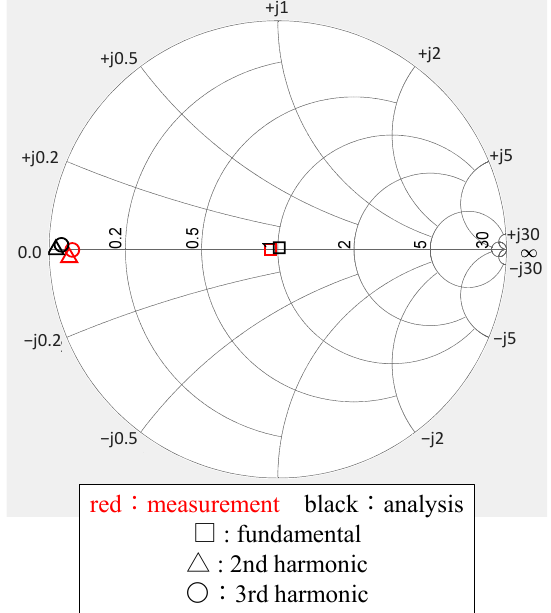
Figure 13. Impedance of the proposed patch antenna at fundamental and each harmonic frequency (measurement and analysis). The reference impedance is 100 ohm, the optimal load impedance of the integrated power amplifier.